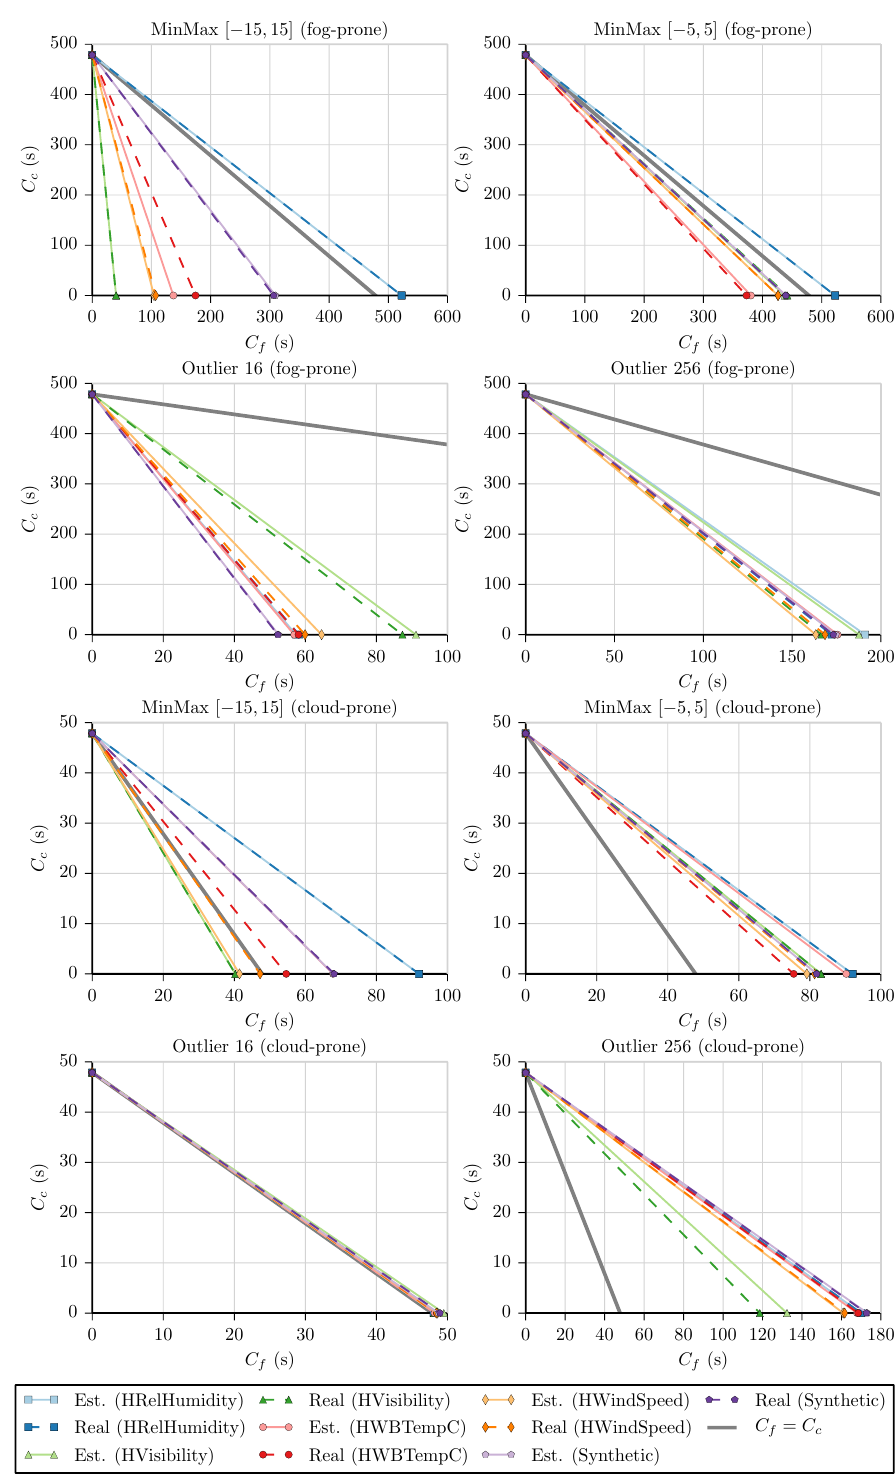
Figure 10. Graphs of the linear equations for each dataset and benchmark using execution time as the cost. Est.,